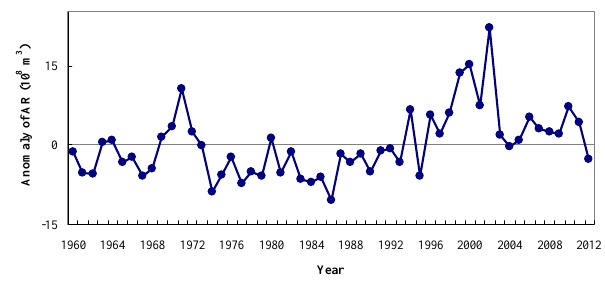
Figure 6. The anomaly time series of AR in the Kaidu River during 1960–2012.